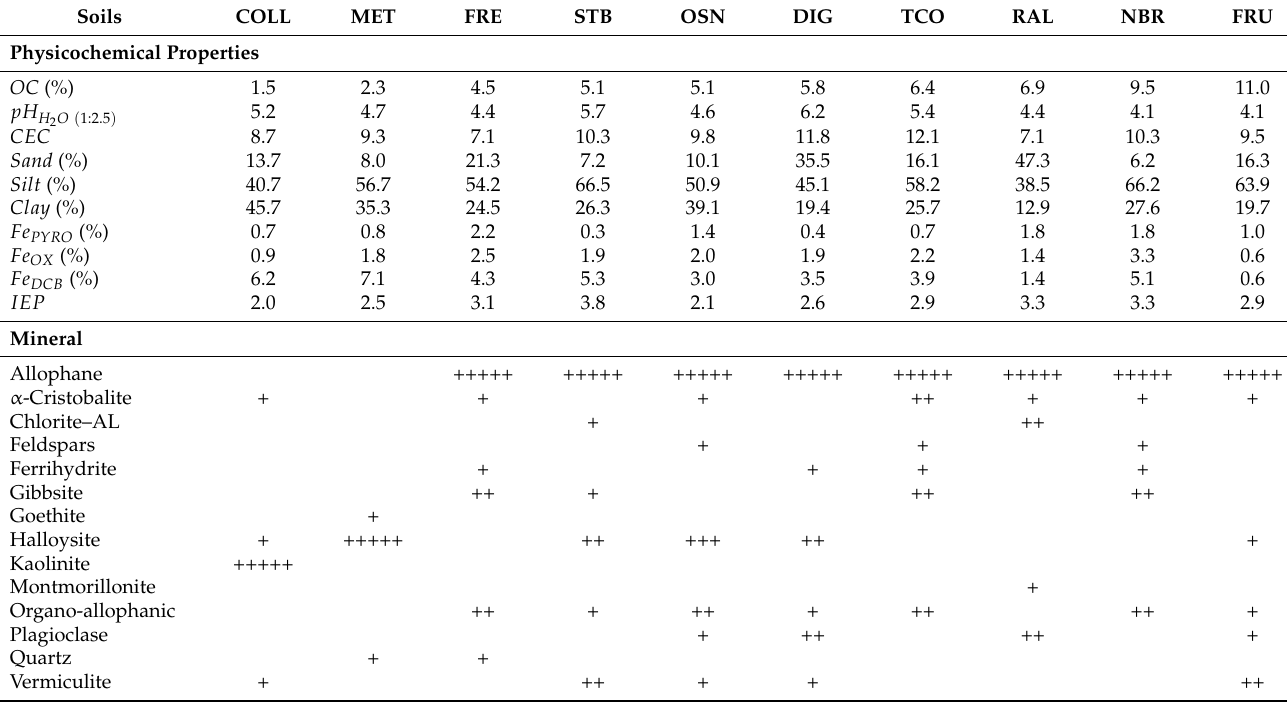
properties like texture, charge, soil constituents, and pH (Table 4). The inter-descriptor correlation coefficient used was less than R 2 < 0.6 to avoid descriptors being intercorrelated. The generated dataset was used in an automated soil descriptors selection procedure using the best subset and stepwise model selection procedures. These methods were used to reduce data dimensionality and determine if a complex model (more soil descriptors) was significantly better than a less complex model. In this regard, K f values for each soil were modeled using VADS properties individually, and the pairwise products of texture soil properties and soil constituents (e.g., Sand × Clay or Fe Pyro × Fe DCB ) to begin to account for interactions between these variables. Additionally, texture soil properties normalized by OC content were included. Table 4. Main physicochemical properties and mineral composition of volcanic ash-derived soils used in this study. Soils COLL Physicochemical Properties OC (%)